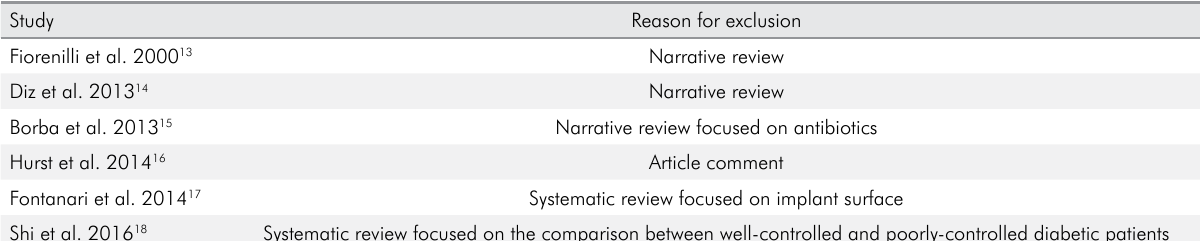
Table 1. List of the excluded